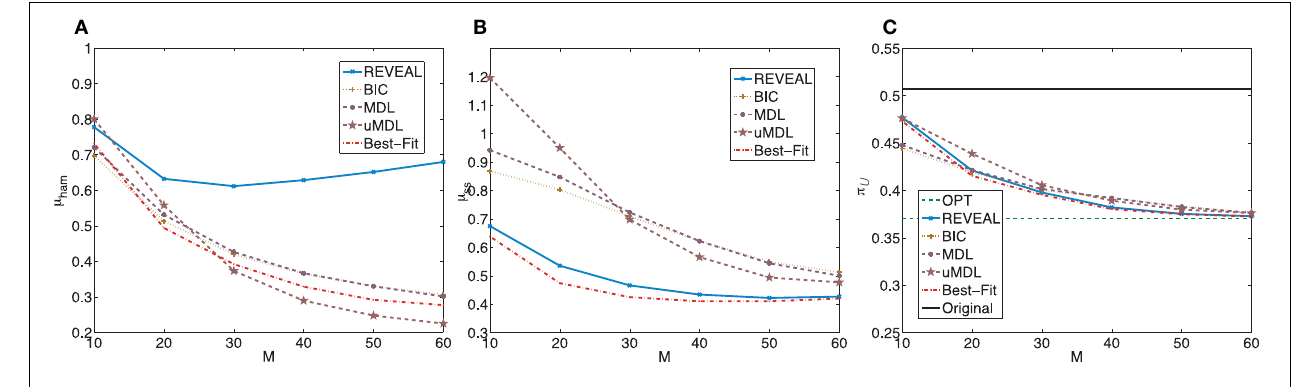
stationary control policies based on inferred networks to the original ground truth BNps, compared to the average undesirable mass obtained by the